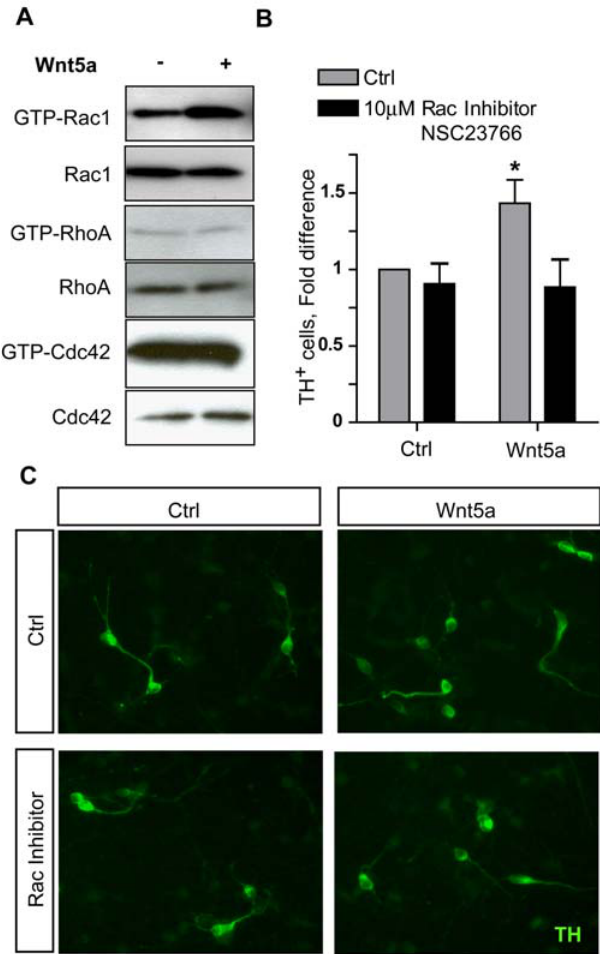
Figure 2. Rac1 is activated by Wnt5a and is required for Wnt5a- induced dopaminergic neuron differentiation. (A) Stimulation of SN4741 cells, a midbrain dopaminergic neuron cell line, with 200 ng/ml Wnt5a for 2 hrs activates Rac1, but not RhoA or Cdc42. (B) As previously reported, Wnt5a upregulates the number of TH + dopaminergic neurons in E11.5 primary ventral midbrain cultures grown for three days in vitro. This differentiation is completely inhibited in the presence of 10 m M NSC23766, a Rac1 inhibitor (ANOVA for Wnt5a vs Wnt5a&NSC23766, P , 0.05, N=3 experiments, each normalized to the control conditions) (C) TH + cells in all conditions have normal morphology, with increased numbers in the Wnt5a-treated, but not Rac-inhibited, wells. doi:10.1371/journal.pone.0003517.g002 (Figure 3A, D) but not at earlier or later stages (Figure 3B, D and data not shown). TH + cells displayed normal morphology and relatively normal density at E12.5 (Figure 3C). Although the number of DA neurons normal at all ages except E14.5, the morphology of the midbrain and distribution of the DA neurons was altered in Wnt5a 2 / 2 mice from E10.5, note the broader lateral and dorsoventral distribution of TH + cells at E12.5, E14.5 and E17.5 (Figure 4A, B). We also examined the number of cleaved caspase 3 + cells (a marker of cells in apoptosis), but found no difference at E14.5 or E17.5 (data not shown).